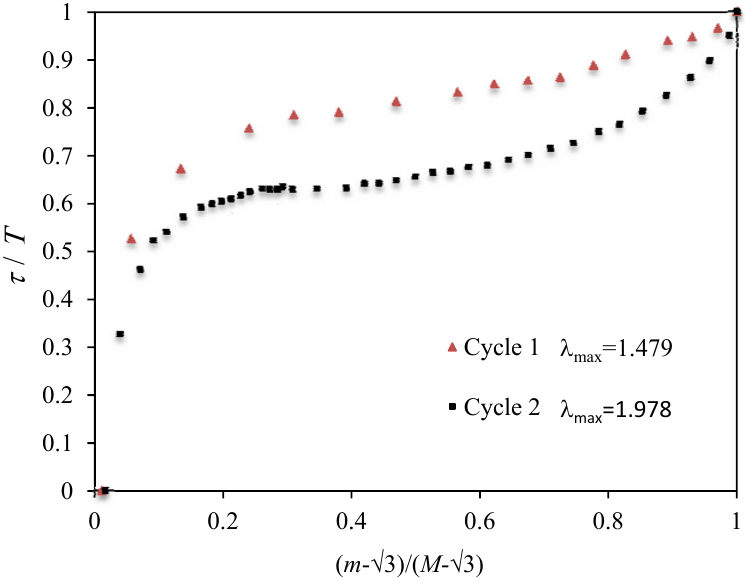
Figure 1. Normalized experimental stress data for the first two loading–unloading cycles of uniaxial tension tests performed in BIMSM-MWCNT (12.2%) composite material plotted against the normalized strain intensity ratio. Experimental data adapted from